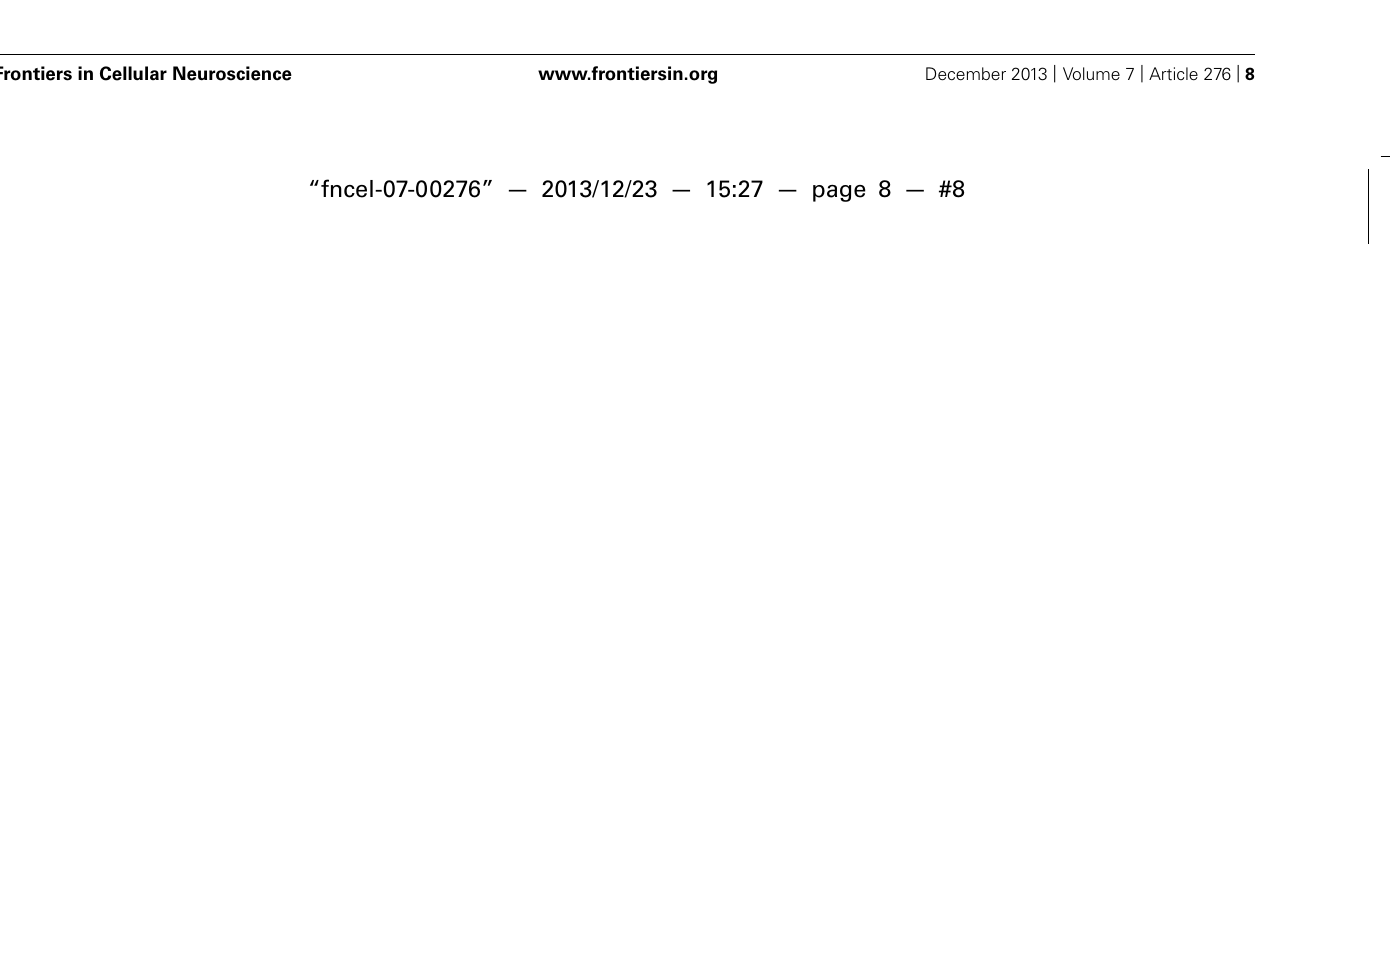
FIGURE 6 | Complex dynamics between plateau properties and stimulation in different receptive field spots.(A) The after-discharge produced by depolarizing current pulses could be turned off by a hyperpolarizing current pulse (a) or by brief brush within the inhibitory receptive field (b) . (B) Gentle mechanical stimulation induced a strong